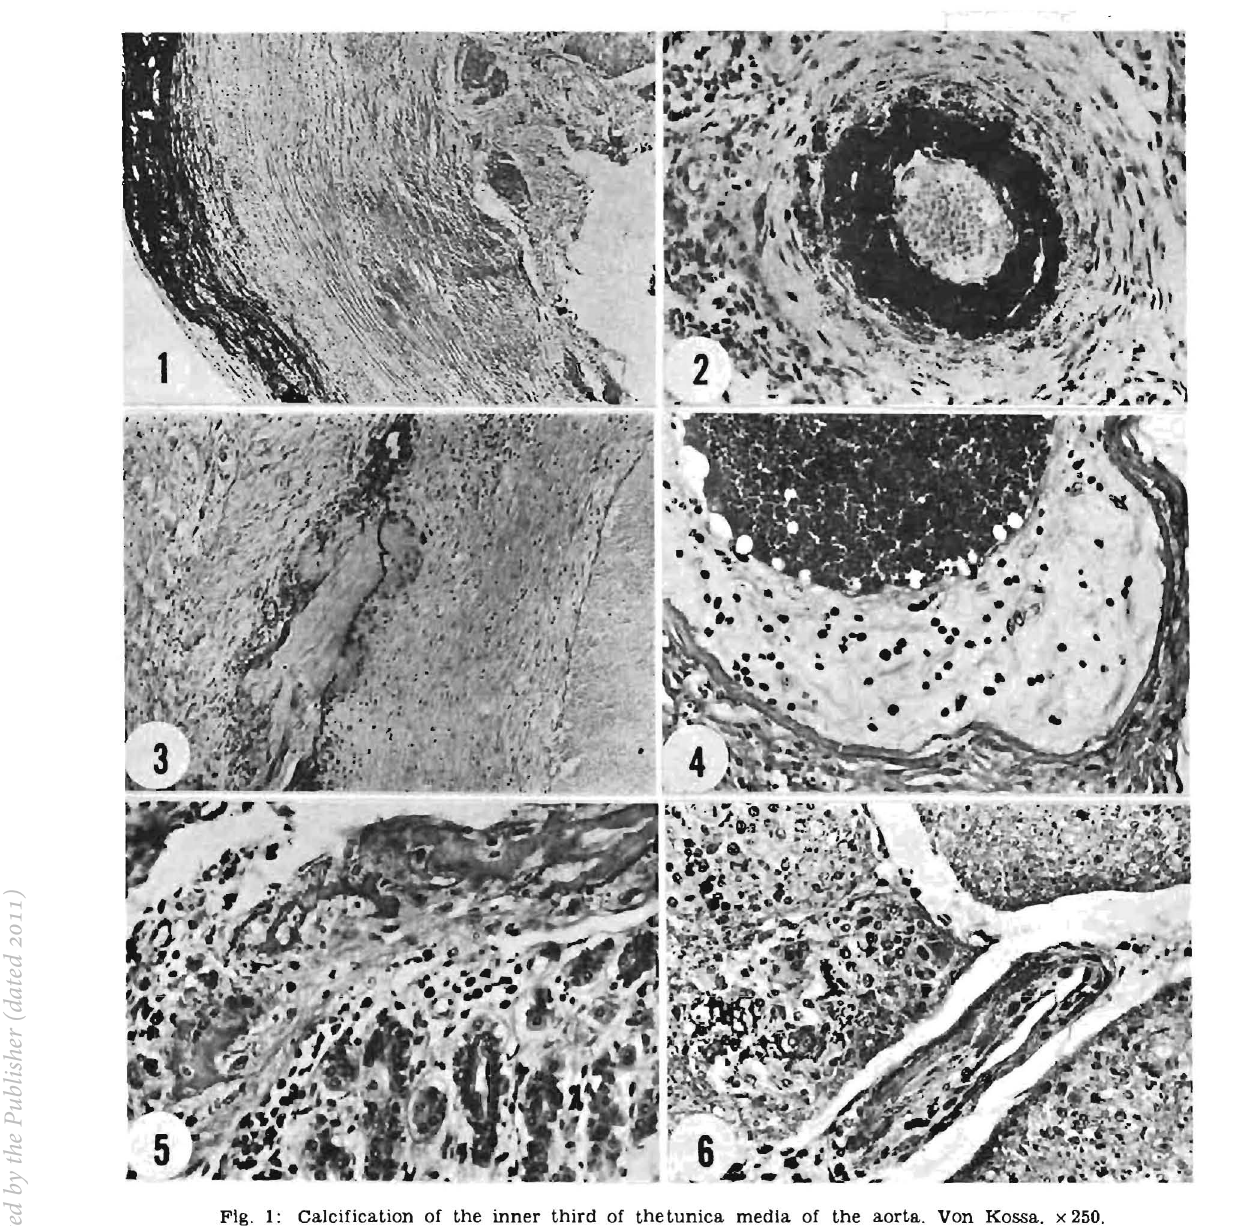
Fig. 1: Calcification of the inner third of the tunica media of the aorta. Von Kossa. x 250. Fig. 2. Media calcification of a muscular artery in the uterus. Von Kossa. x 400. Fig. 3. Subendothelial proliferation of the tunica intima of a branch of the cor.onary artery and the focal deposition of calcium (hOmOgenous, lightly staining area) which has evoked a mild tissue reaction together with some duplication and irregularity of the elastica interna. Verhoeff's elastic stain. x 160. Fig. 4: Subendothelial proliferation and calcification of the elastica intema In the Intima of a small artery In the submucosa of the abomasum. Hand E. x 400. Fig. 5: Calcification of the muscularis mucosae of the abomasum. Hand E. x 400. Fig. 6: Focal degeneration and calcification of the smooth muscle in the wall of the rumen and partial mineralization of an adjacent sma)) artery. Hand E. x 400.